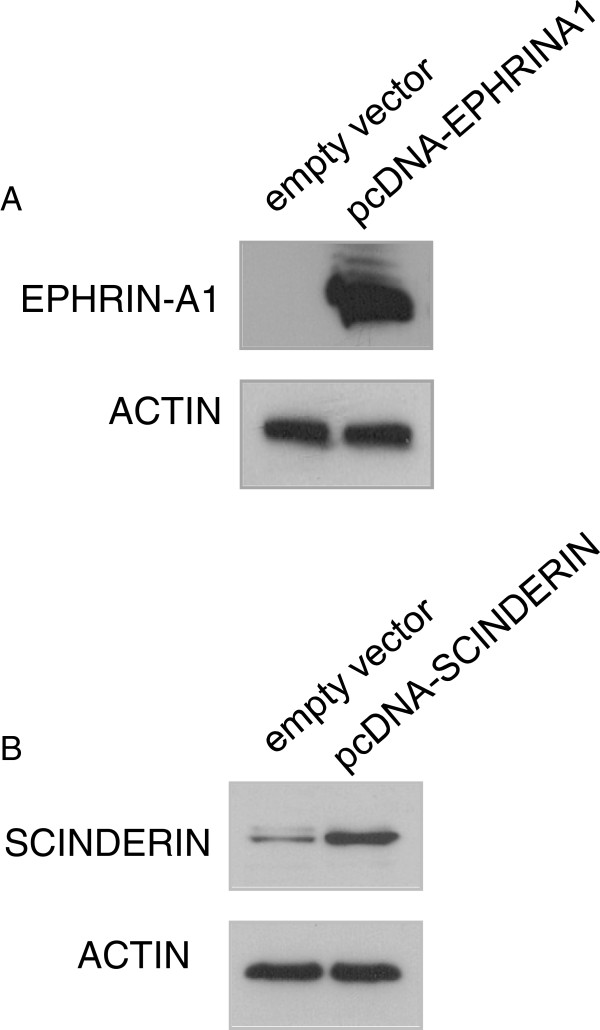
Western-blot analysis of anti-EPHRIN-A1 and anti-SCINDERIN antibody specificity. Non-small cell lung carcinoma cells (IGR-Heu) were transfected with empty vector or plasmids encoding either EPHRIN-A1 or SCINDERIN. Antibody specificity was further assessed by western-blot analysis of protein cell extracts.